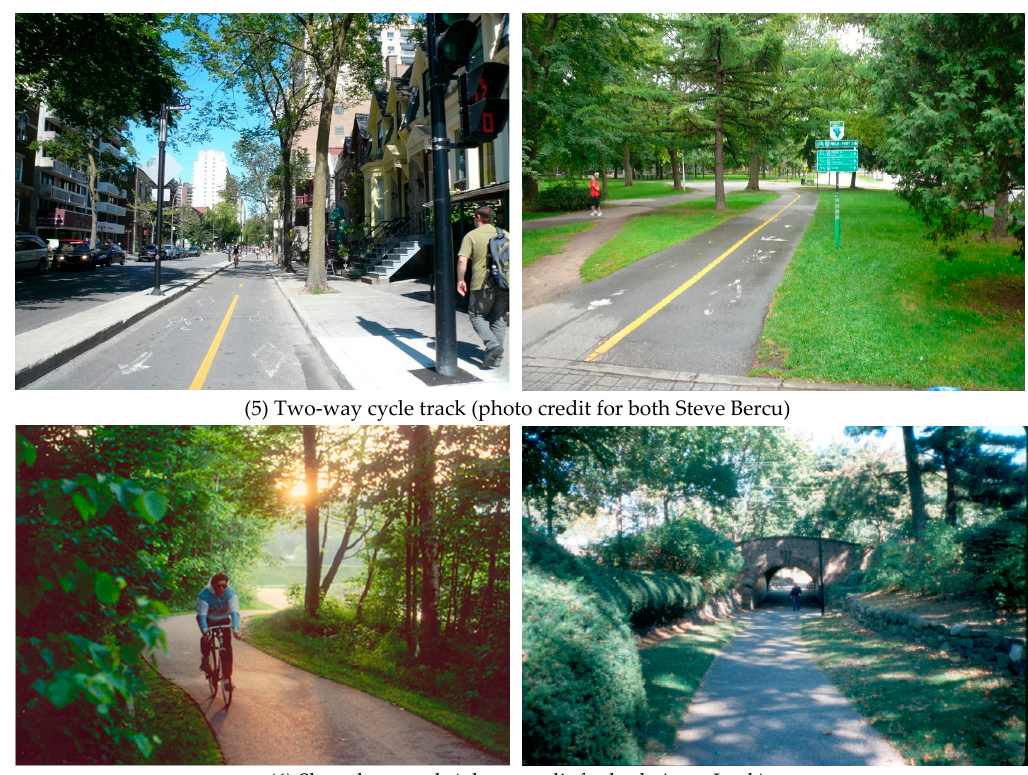
Figure 1. Two pictures of each of the facility types included in the survey of 32 slides.